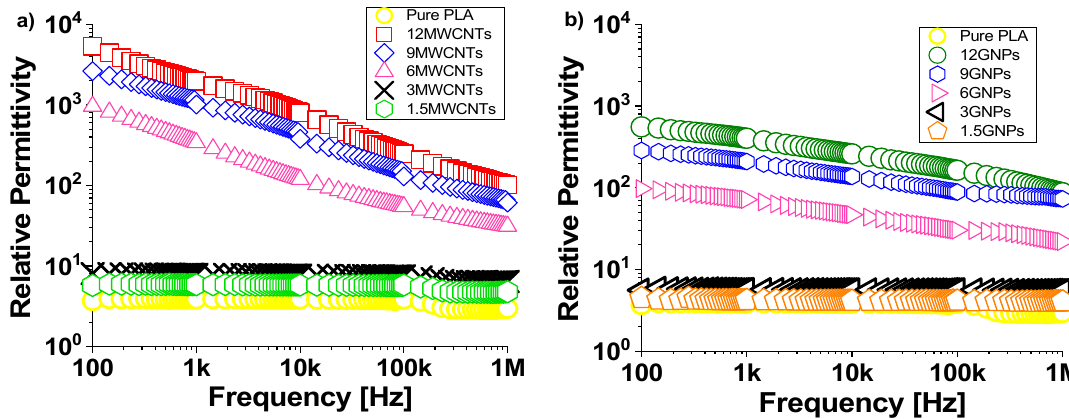
Figure 15. Evolution of relative permittivity as function of frequency in the range [100 Hz–1 MHz] for PLA reinforced with MWCNTs and GNPs, in ( a ) and ( b ), respectively.